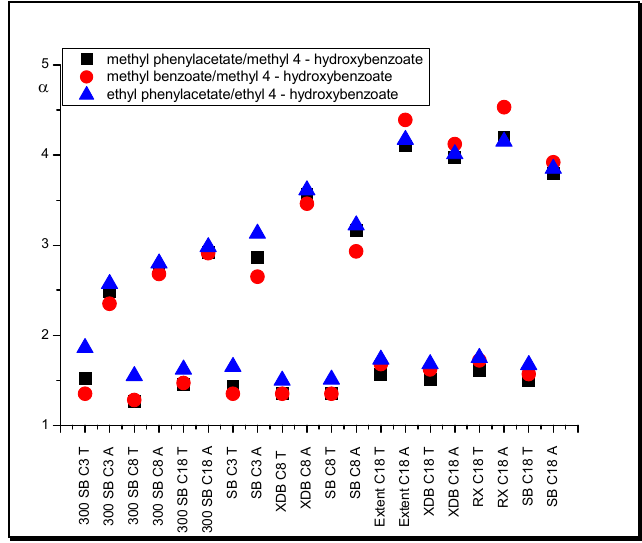
Figure 2. Separation factor, α , values of esters in systems with different nonpolar stationary phases and acetonitrile (A) in water and tetrahydrofuran (T) in water (modifier concentrations as in Table 1). Another example of selectivity changes demonstrates the 4 ‐ nitrobenzaldehyde/4 ‐ cyanobenzaldehyde pair. The higher value of the retention of the first substance in relation to the